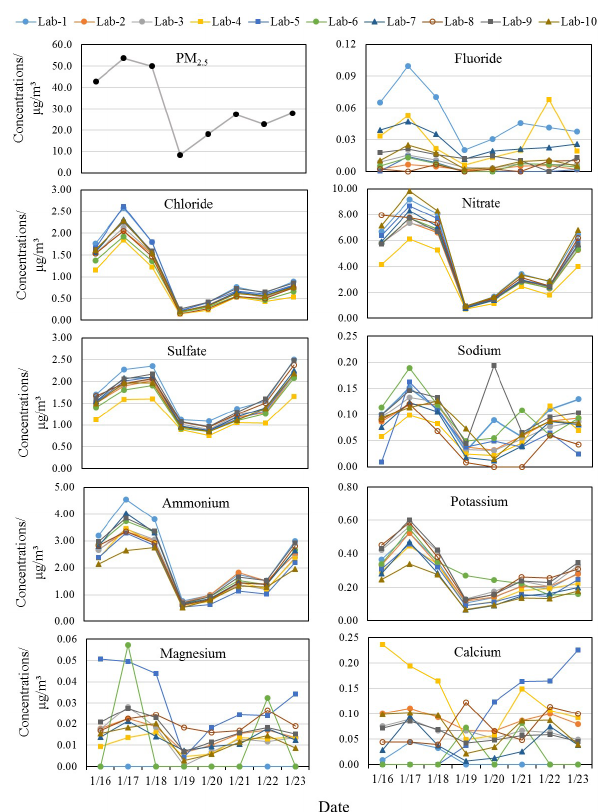
Figure 1. The time series of mass concentrations of PM 2 . 5 and ions. The date is given in the format